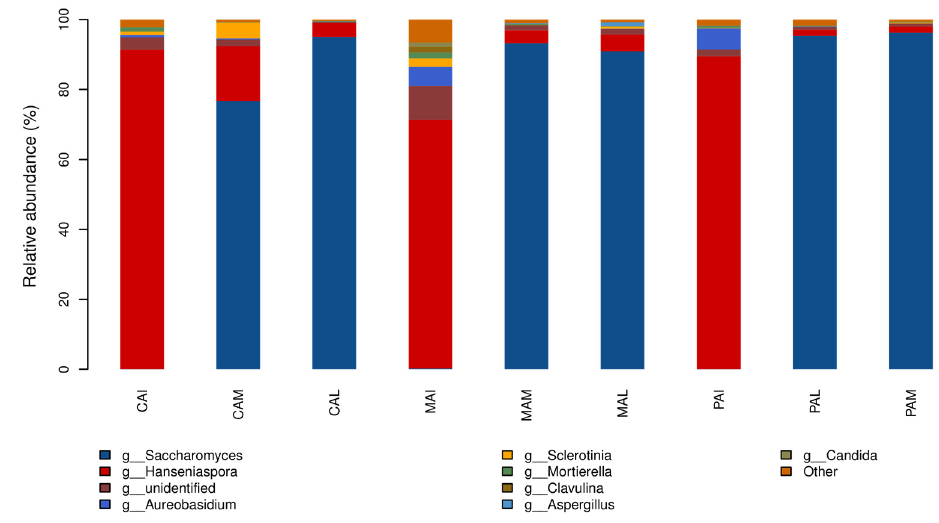
Figure 6. Histogram of species composition of genus-level samples. CAI is the pre-fermentation Cabernet Sauvignon, CAM is the mid-fermentation Cabernet Sauvignon, and CAL is the late fer- mentation Cabernet Sauvignon. MAI is the pre-fermentation Matheran, MAM is the mid-fermenta- tion Matheran, and MAL is the late fermentation Matheran. PAI is the pre-fermentation Cabernet Franc, PAM is the mid-fermentation Cabernet Franc, and PAL is the late fermentation Cabernet Franc.